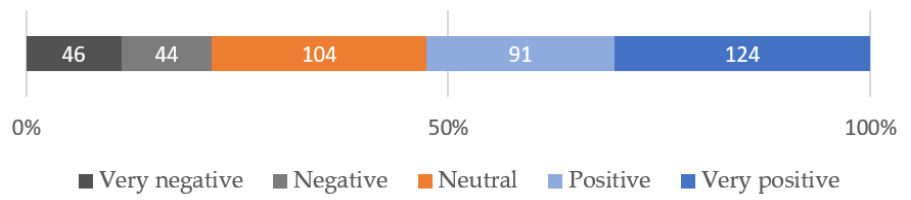
Figure 2. Respondent distribution by level of attitude.